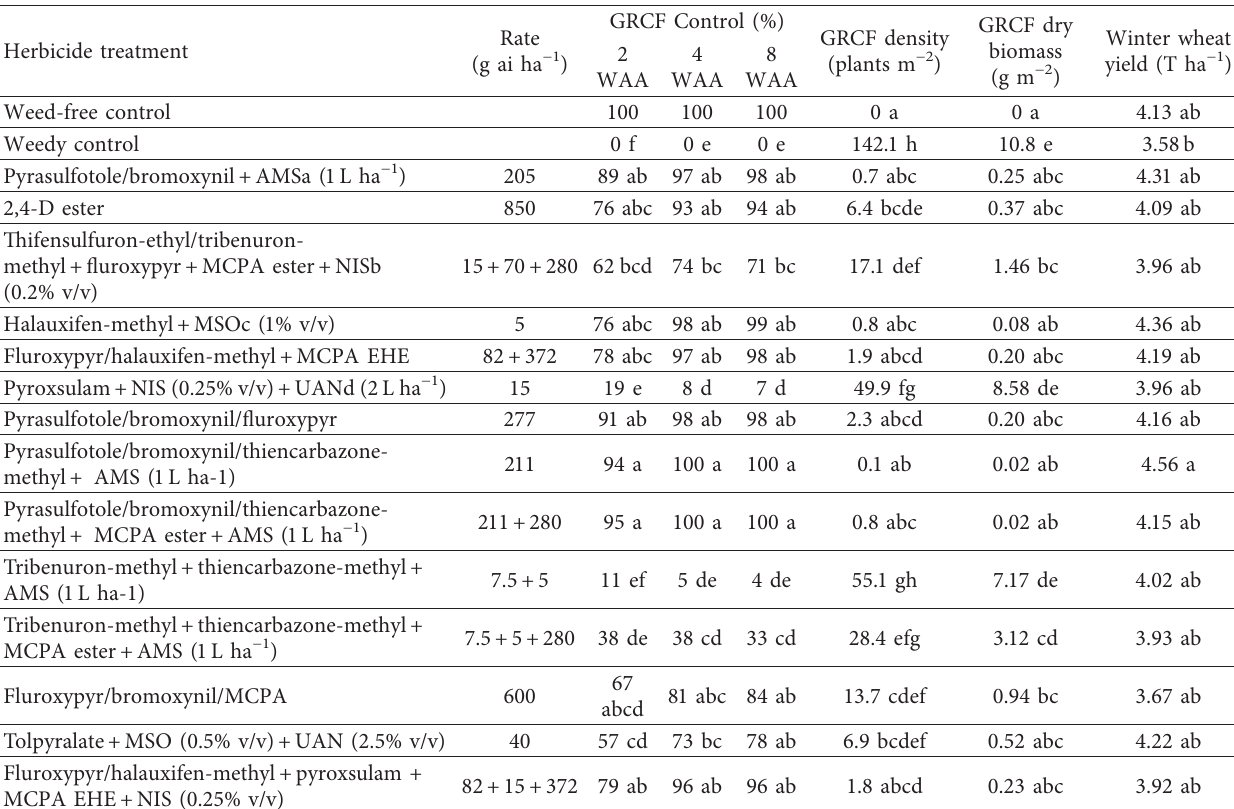
Table 1: Glyphosate-resistant Canada fleabane (GRCF) control 2, 4, and 8 weeks after herbicide application (WAA), GRCF density, and dry biomass 4 WAA and winter wheat yield for herbicides applied postemergence from 6 sites in southwestern Ontario in 2018–2019. Herbicide treatment